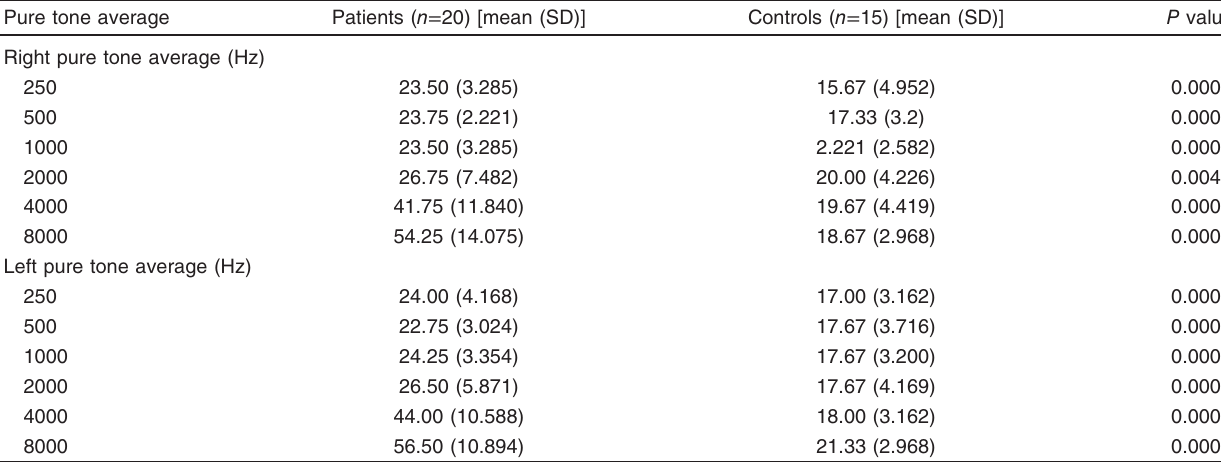
Table 1 Comparison of the mean hearing thresholds in patients with Parkinson disease and controls regarding pure tone average (dB HL) in the right and left ears